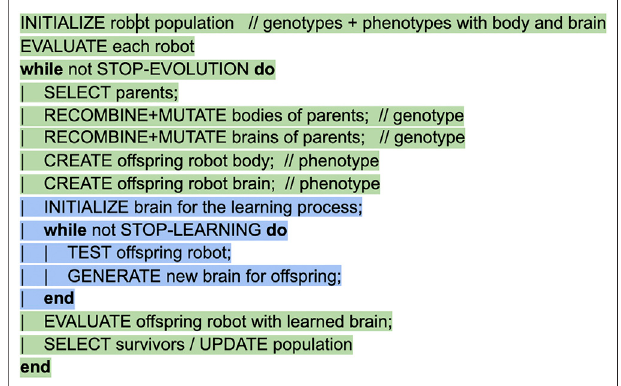
FIGURE2| PseudocodeforrobotevolutionbasedontheTriangleofLife framework. Following the color code of Figure 1 , the green lines correspond to the main evolutionary loop, the blue ones show the learning loop during the infancy stage. Note that the dichotomy of body and brain in the robots ’ makeup translates to twofold genotypes divided into a body-coding segment and a brain-coding segment. These segments can have their speci fi c recombination and mutation